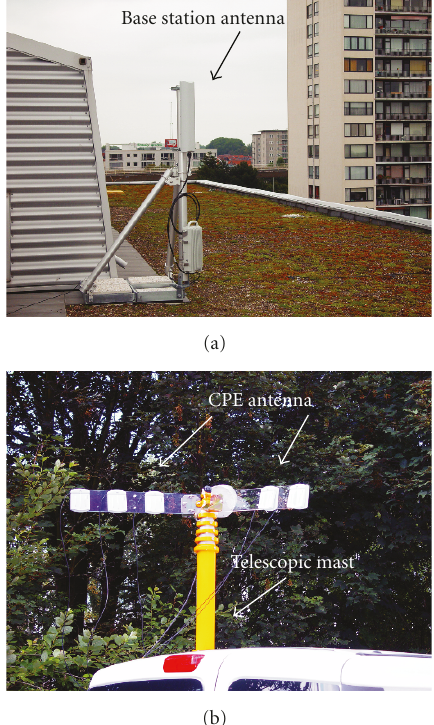
Figure 1: Pictures of (a) base station antenna on roof ( h BS = 15m) and (b) CPE antennas mounted on telescopic